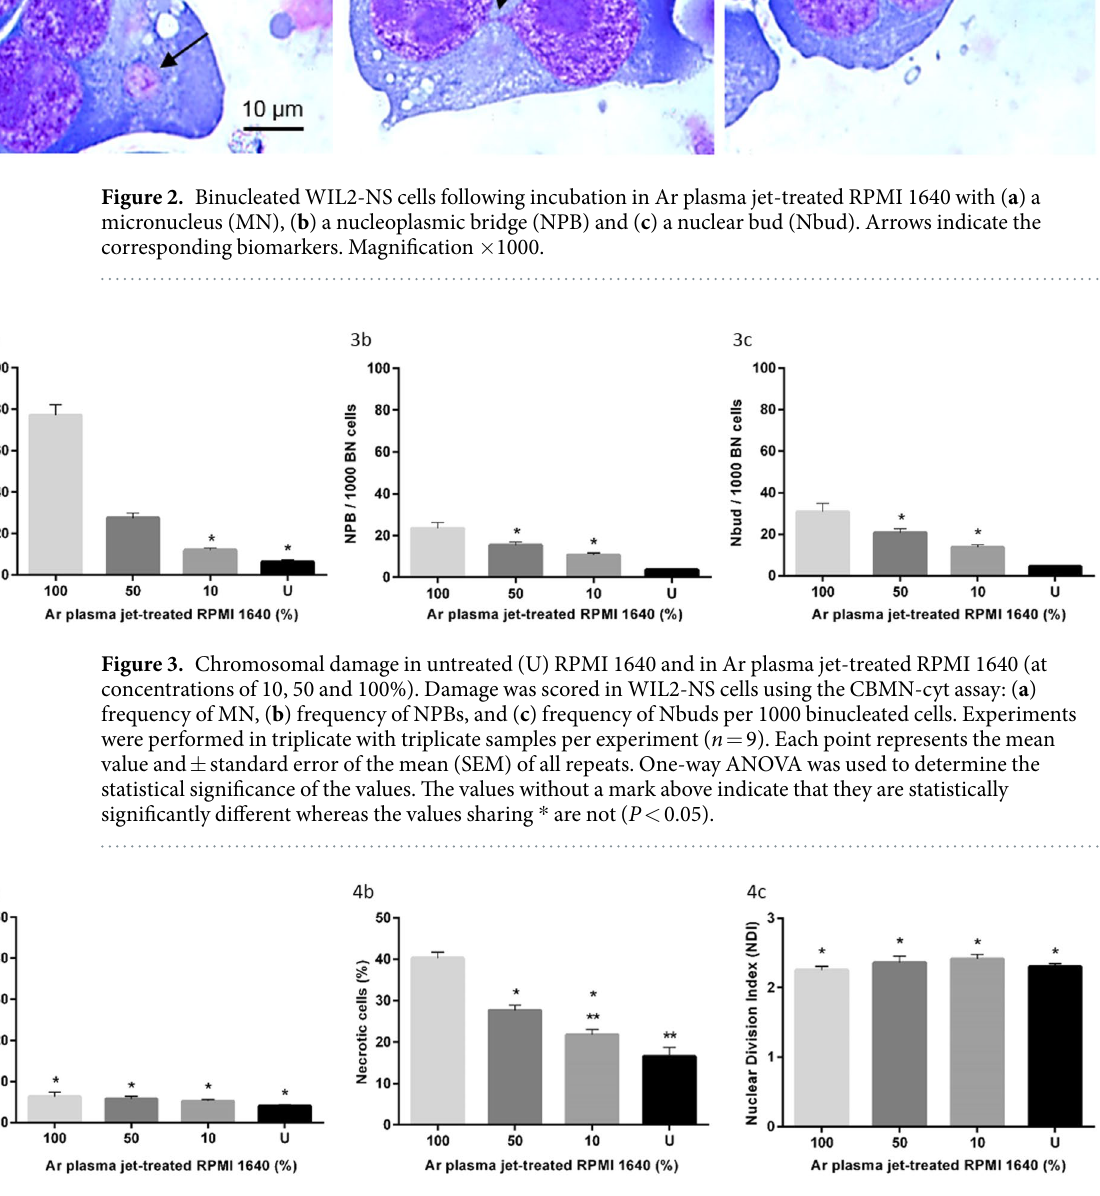
4 Scientific RepoRts | 7: 3854 | DOI:10.1038/s41598-017-03754-1